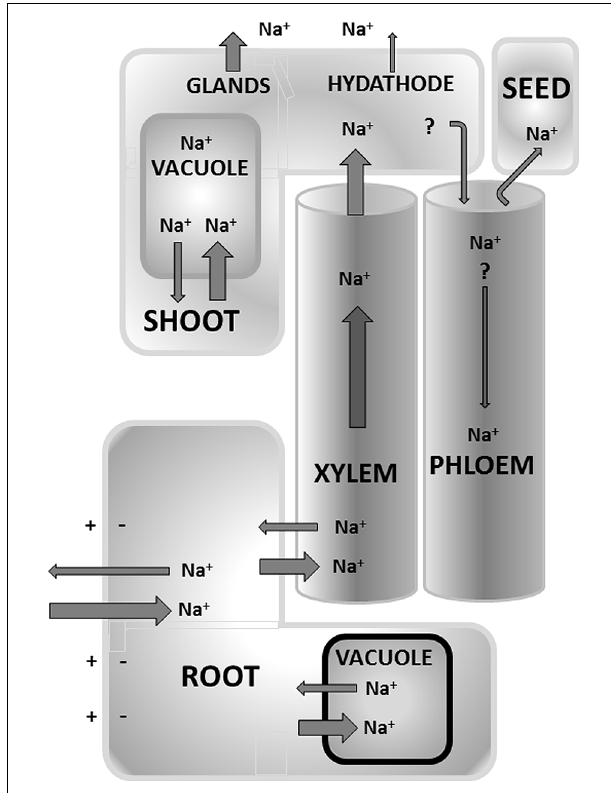
FIGURE 1 | Overview of the main Na + flux pathways that occur in terrestrial plants. Some mechanisms are still debated such as recycling of Na + from shoot to root via the phloem. Other mechanisms are anatomic adaptations found in a limited number of (halophytic) species only, such as extrusion via glands and hydathodes.The size of the arrow only provides a relative measure of various fluxes but is not meant to be quantitative.